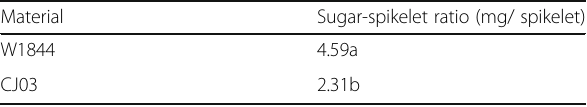
Table 5 Sugar-spikelet ratio of the test materials at heading Material